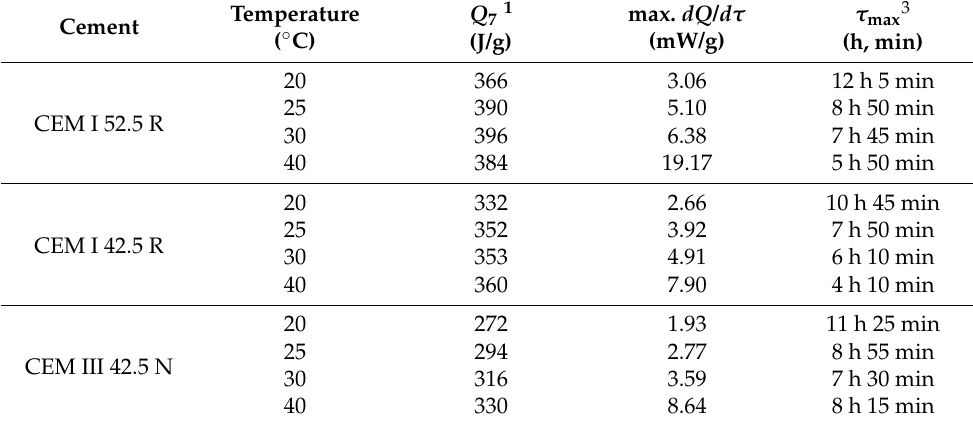
Table 2. Results of calorimetric tests for studied